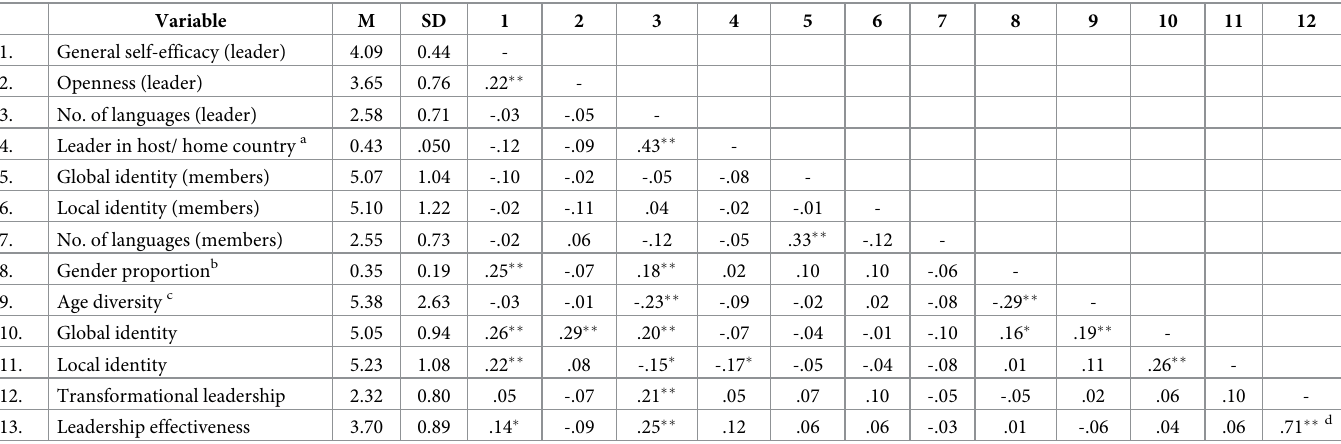
Table 1. Descriptive statistics and correlations for study variables.